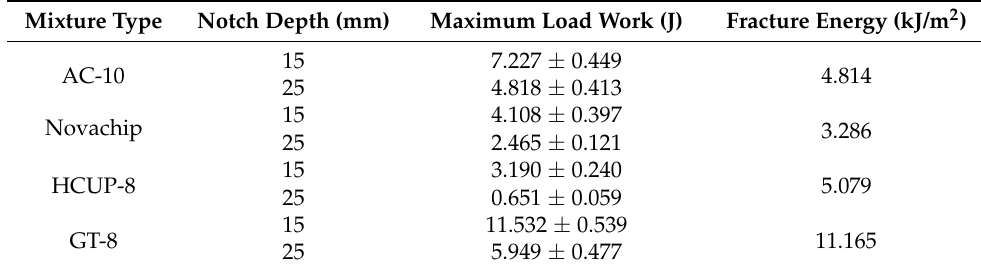
Figure 9. Load work calculation curve for semicircular bending test: ( a ) the notch depth is 15 mm; ( b ) the notch depth is 25 mm. Table 13. Results of semicircular bend test.